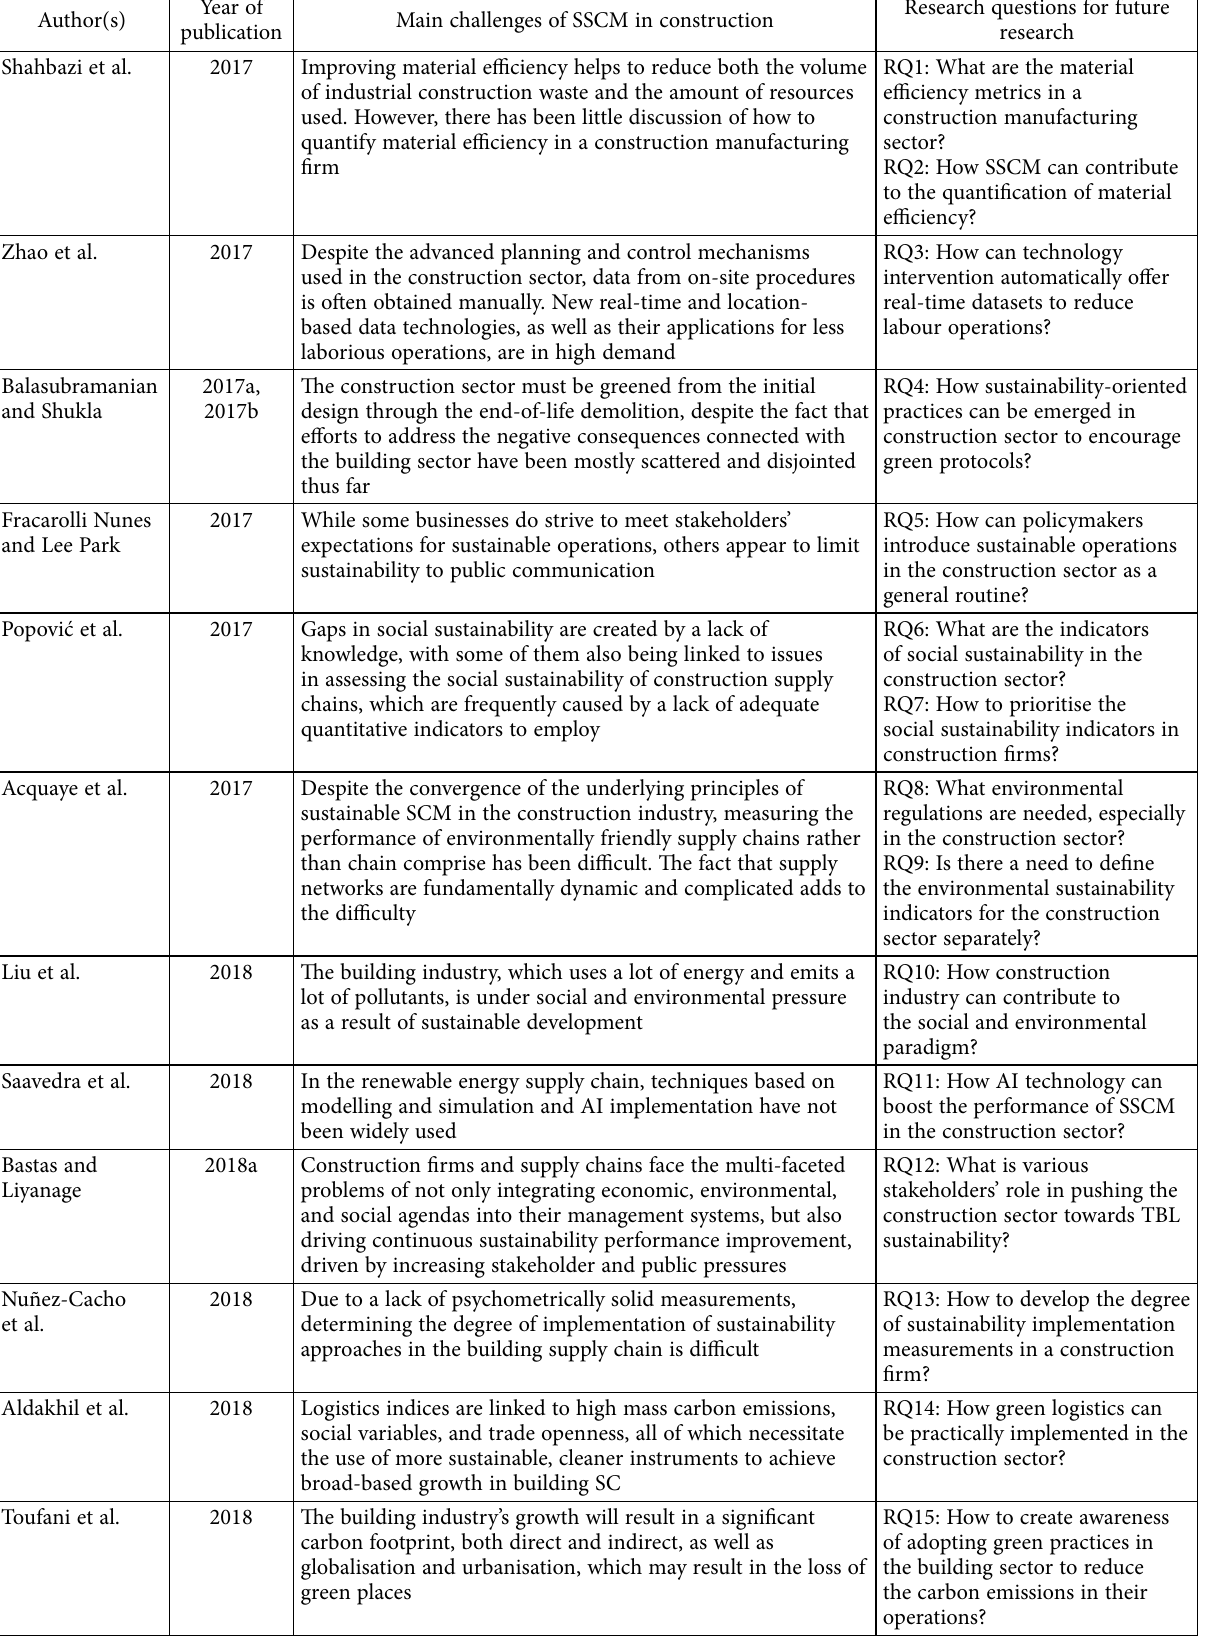
Table 2. Future research questions emerge from challenges and barriers of SSCM in